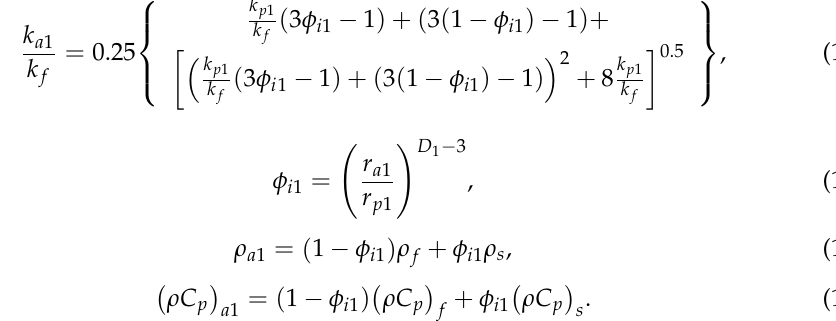
Table 1. Thermophysical properties of nanomaterials. S.